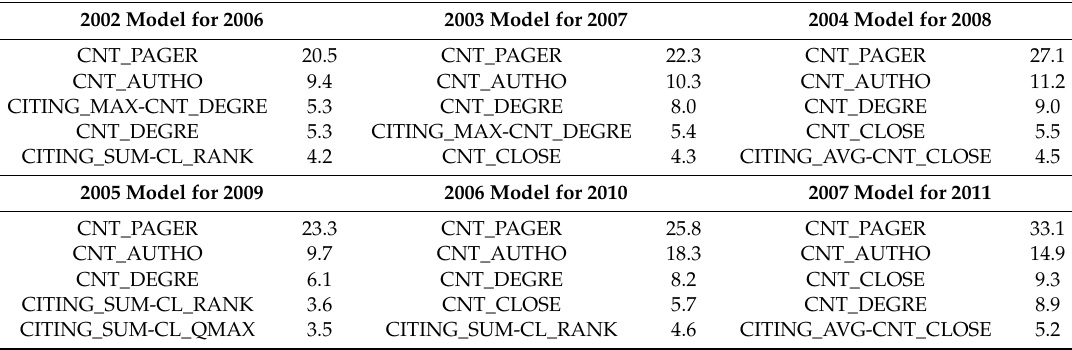
Table 4. Top five features contributing in the model for each